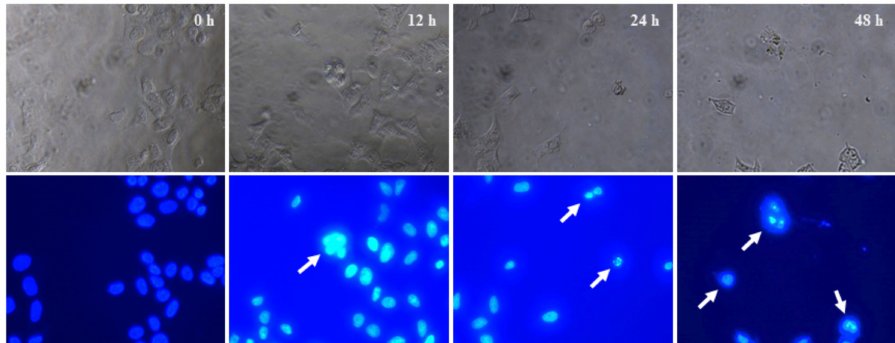
Figure 7. Immunocytochemistry DAPI staining. Effects of Q3G on HeLa cells treated for 12, 24, and 48 h. Control cells showed intact nuclei, whereas all the other groups presented significant visible damage in the nuclei